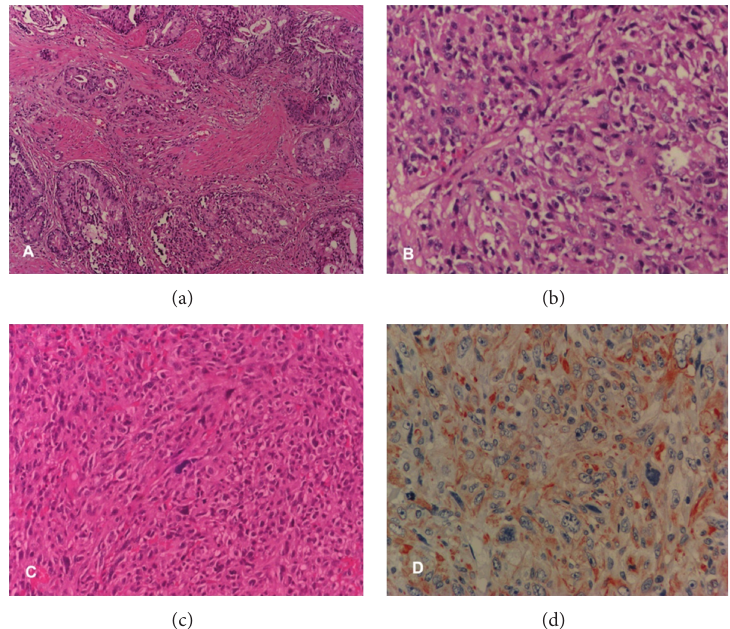
Figure 1: (a) Gleason 5 + 3 = 8 prostate adenocarcinoma in pathological examination of the first TUR-P material (an area which has more glands). (b) Undifferentiated tumor cells in pathological examination of the second TUR-P material. (c) Sarcomatous areas in the last TUR-P material (spindle and rare bizarre cells). (d) Sarcomatoid cells in immunohistochemical examination (vimentin positive/AEC